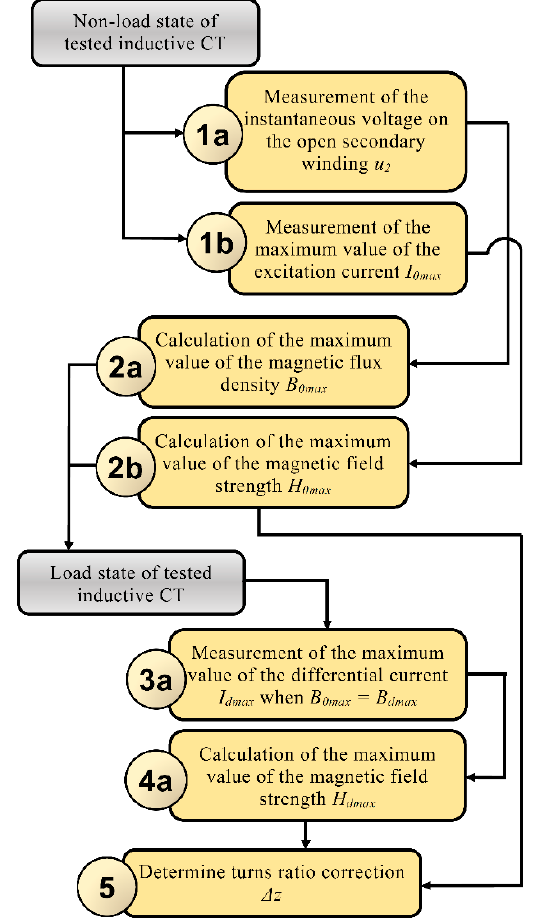
Figure 3. The flowchart of the developed method to determine the turns ratio correction of the CT.